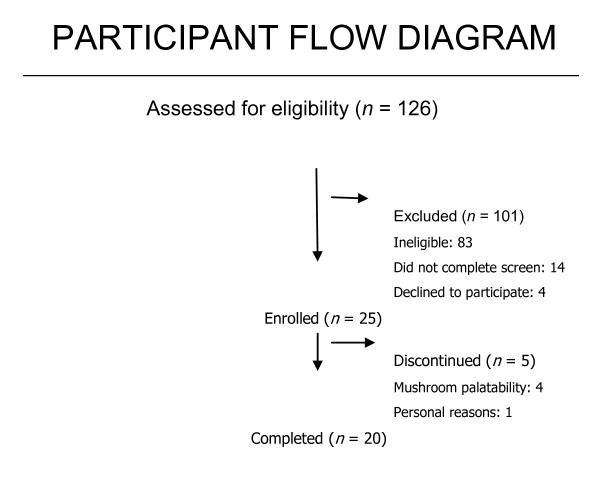
Study Participant Flow Sheet.